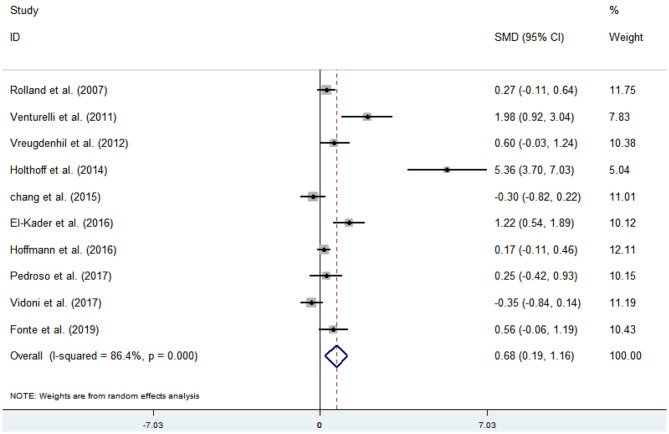
Effect of physical activity on ADLs.